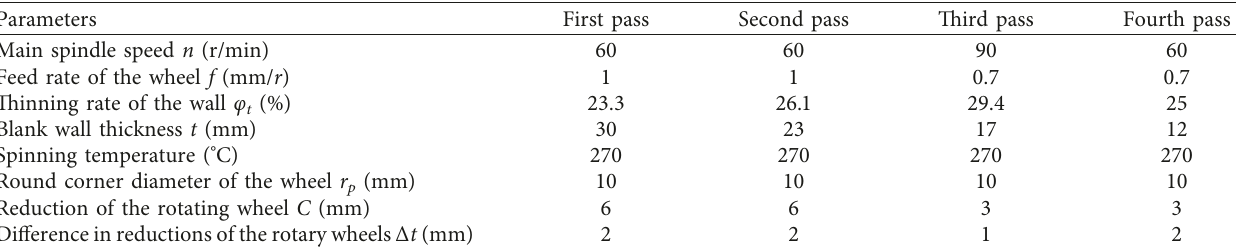
Figure 6: Simulation models. (a) Blank material model. (b) Spinning wheel models. (c) Mandrel Table 4: Multipass numerical simulation spinning process parameters of magnesium alloy cylindrical parts.